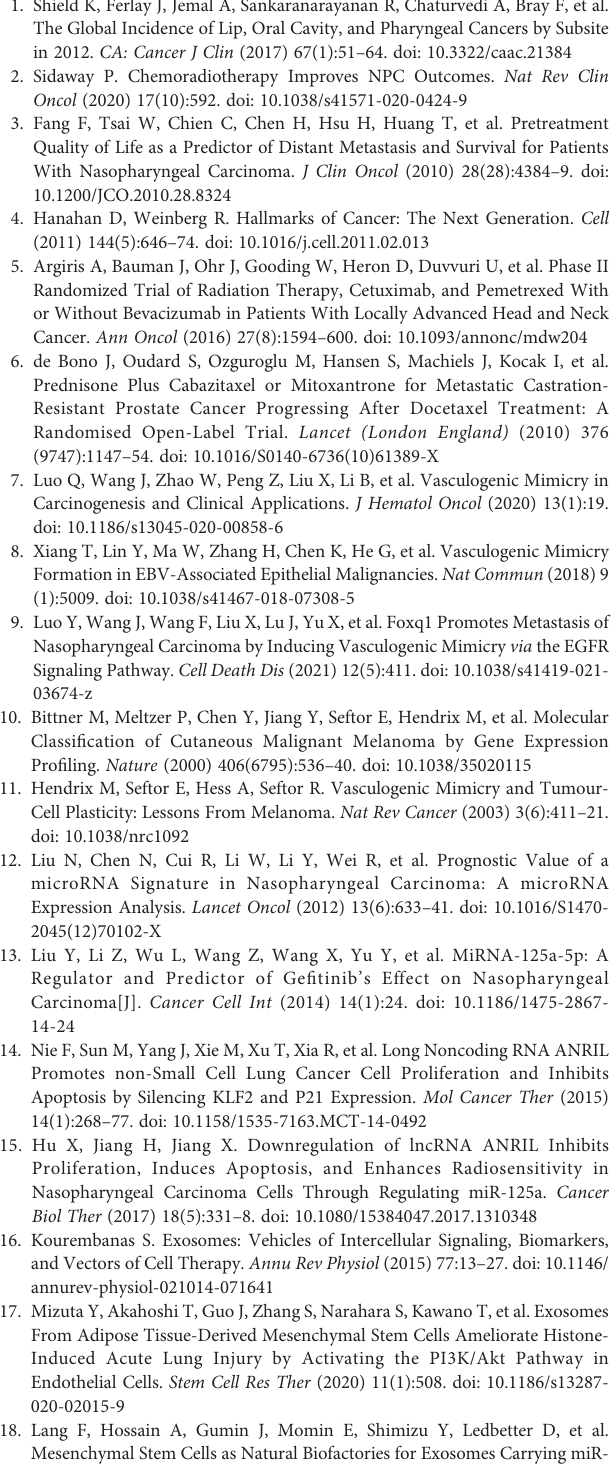
Supplementary Figure 1 | Protein level after knockdown or upregulation miR- 125a. (A) Expression of TAZ reduced after up-regulated the miR-125a level, and